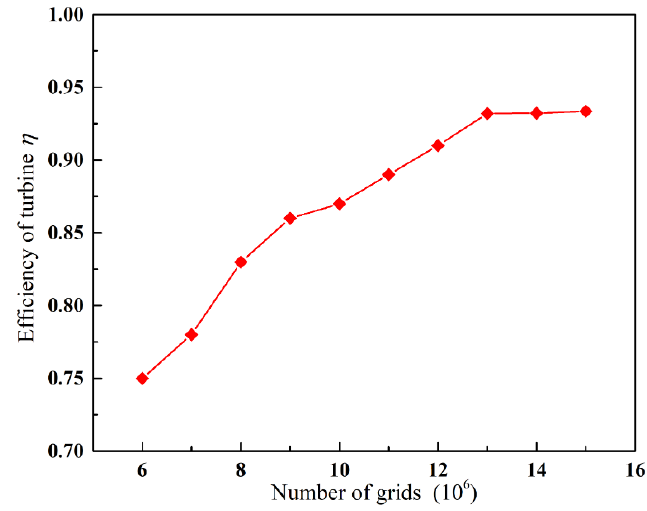
Figure 4. Grid independence verification.